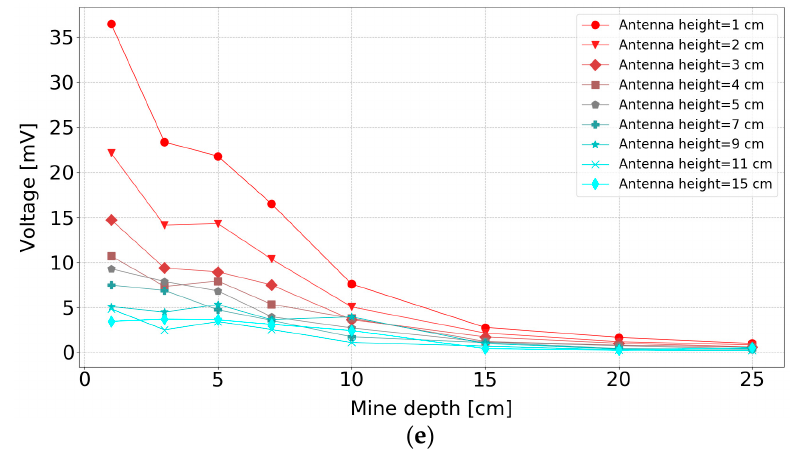
Figure 8. Antenna height above soil for a 9 cm antenna separation: ( a ) Lossless soil with a relative permittivity of 20 (simulation); ( b ) lossy soil with a relative permittivity of 20 (simulation); ( c ) loss-less soil with a relative permittivity of 8 (simulation); ( d ) lossy soil with a relative permittivity of 8 (simulation); ( e ) loamy soil (measurement).